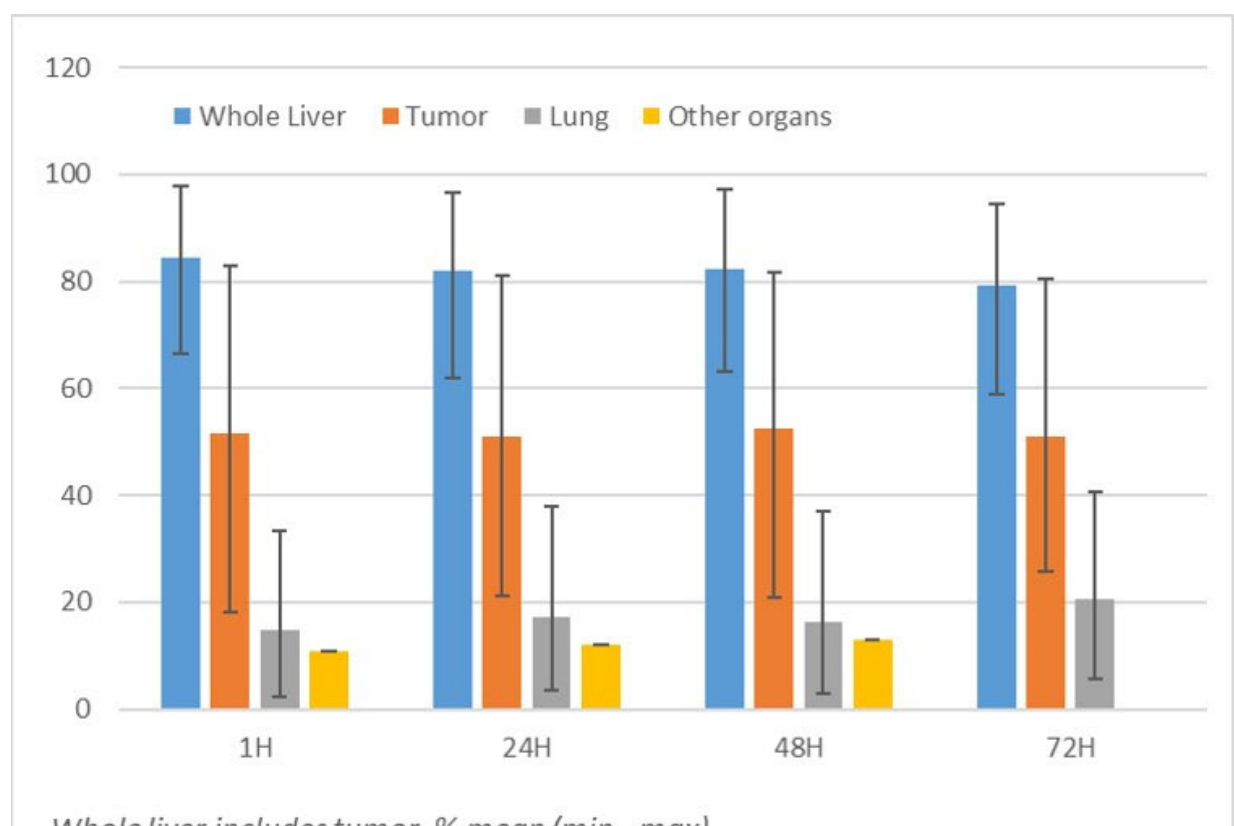
Figure 1. 188 Re-SSS lipiodol SPECT/CT.